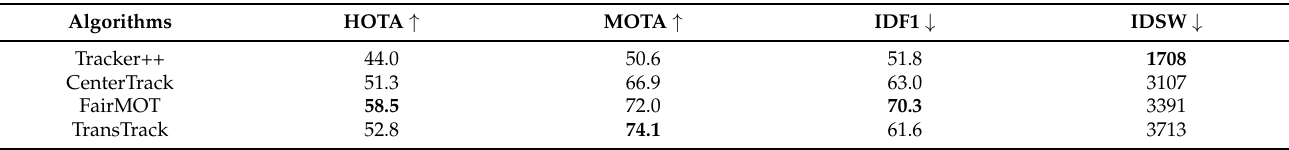
Table 4. Comparison of the candidate methods under the “private detector” protocol on MOT17 training